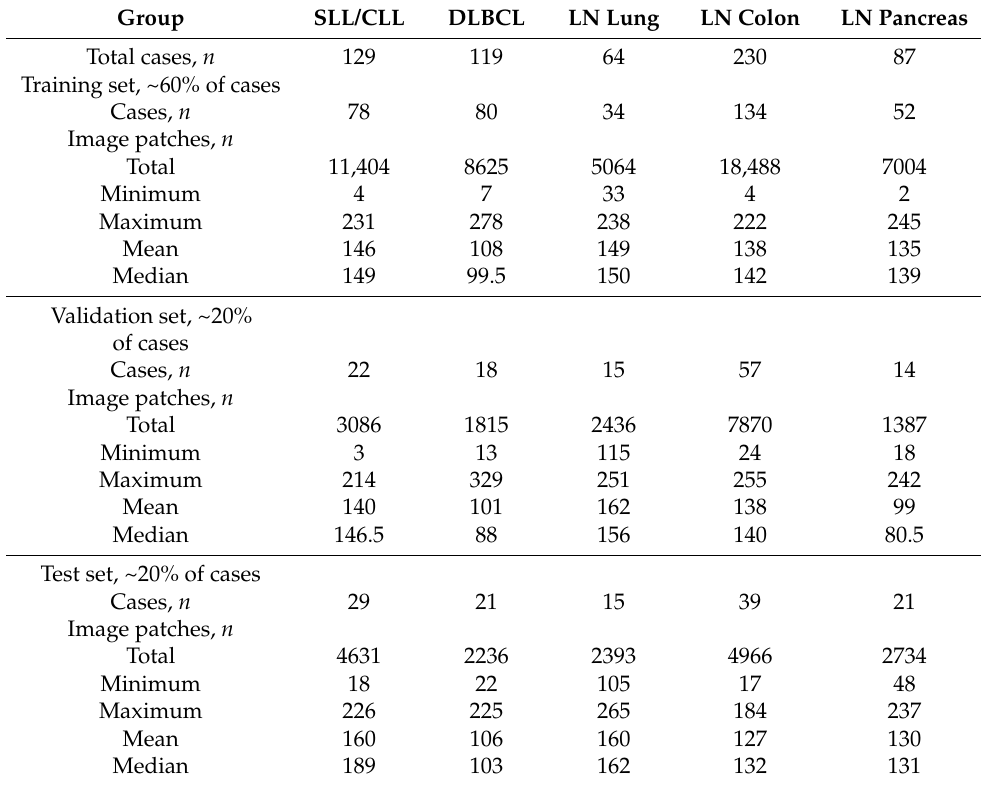
the respective confusion matrices on the validation data of the B3 model were slightly more accurate. Thus, we chose the B3 model to classify the test set. Table 1. Number of extracted image patches per group.